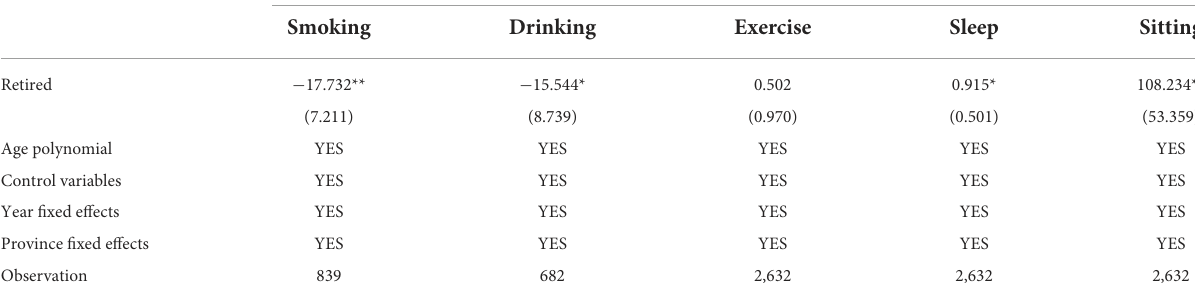
TABLE 8 Sensitivity test of window width